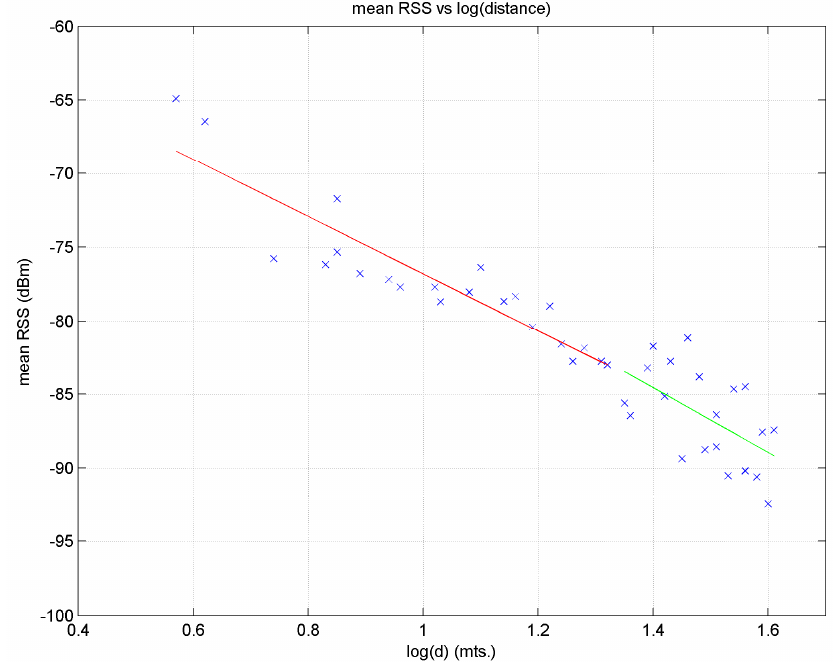
Figure 19. Linear regression for beacon 1 using all the reference points.